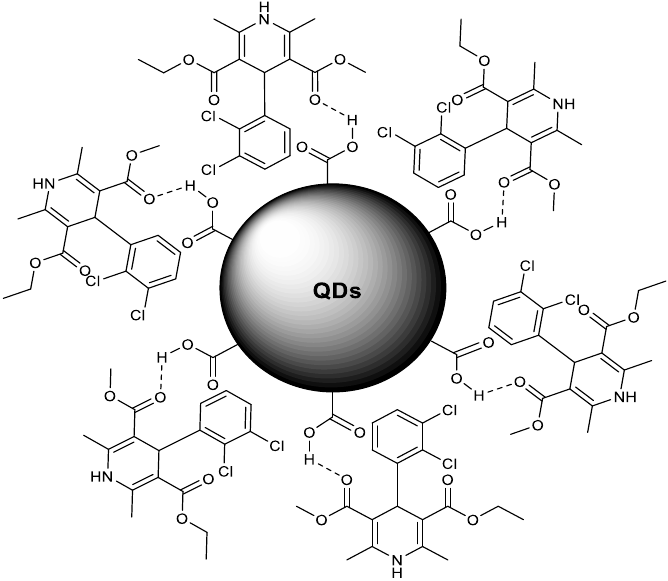
Figure 7. Simulation diagram of the interaction between FEL and CdTe QDs.